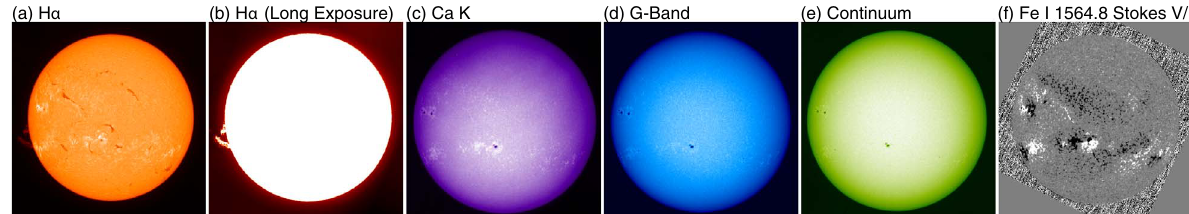
Fig. 2. Sample full-disk images of the Sun on October 19, 2015 taken using the SFT. The images in panels (a) and (b) were taken with the T1 H a imager while those in (c) – (e) were taken with the T4 fi lter imager. The circular polarization (Stokes V / I ) map in (f) was obtained using the infrared spectropolarimeter; the display range is ± 0.2%.